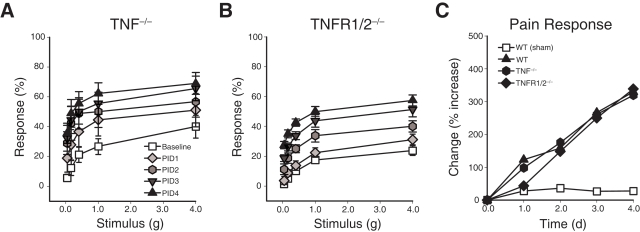
TNF does not mediate cystitis pain.A) TNF−/− mice exhibit normal, progressive pelvic sensitivity following PRV infection (n = 9). B) TNFR1/2−/− mice exhibit normal, progressive pelvic sensitivity following PRV infection (n = 8). In (A) and (B), error bars depict SEM. C) TNF−/− and TNFR1/2−/− mice exhibit overall responses to pelvic stimulation that are indistinguishable from wild type B6 mice (B6). Percent responses at each PID were calculated as total responses to all fibers relative to baseline responses. The symbol key shown in (A) applies to panels A–B.